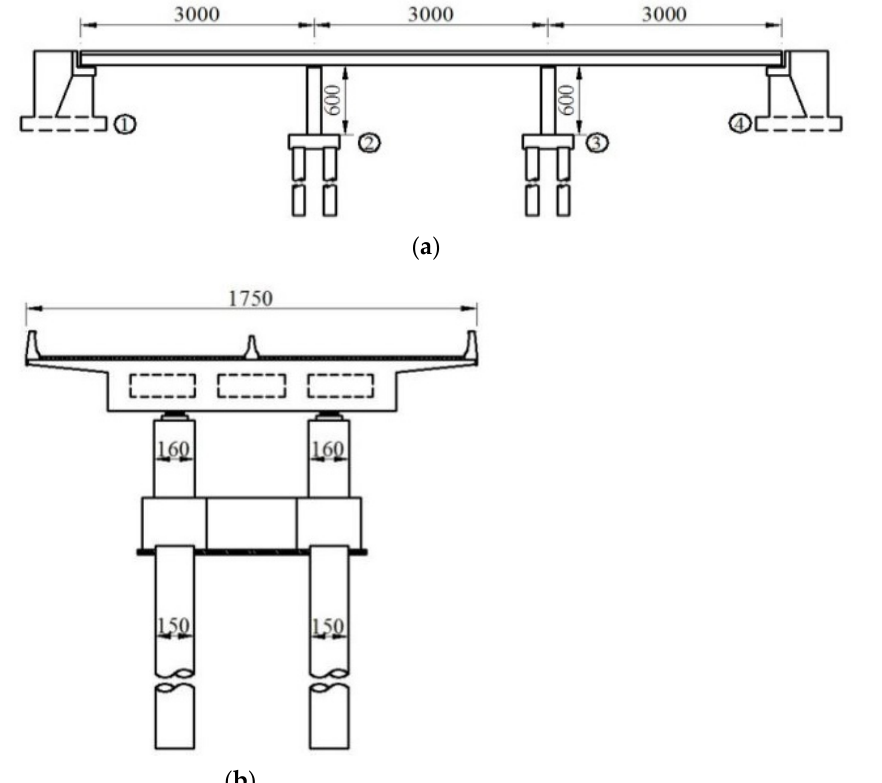
Figure 4. Illustration of the bridge (unit: cm): ( a ) longitudinal profile showing spans of bridge; and ( b ) the transverse profile showing the width of the bridge.